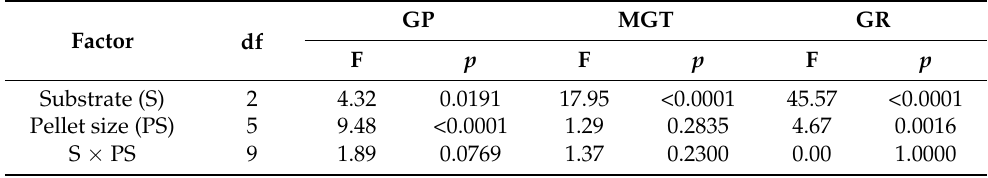
Table 3. Results of two-way ANOVA for the effect of the soil substrate and size of pelleted seeds on the germination percentage (GP), mean germination time (MGT), and germination rate (GR). GP MGT GR Factor df F p F p F Substrate